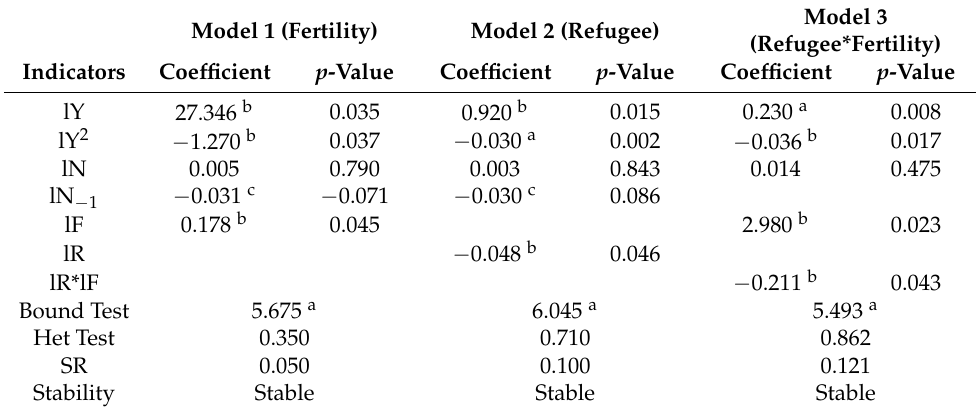
Table 7. ARDL Sweden.